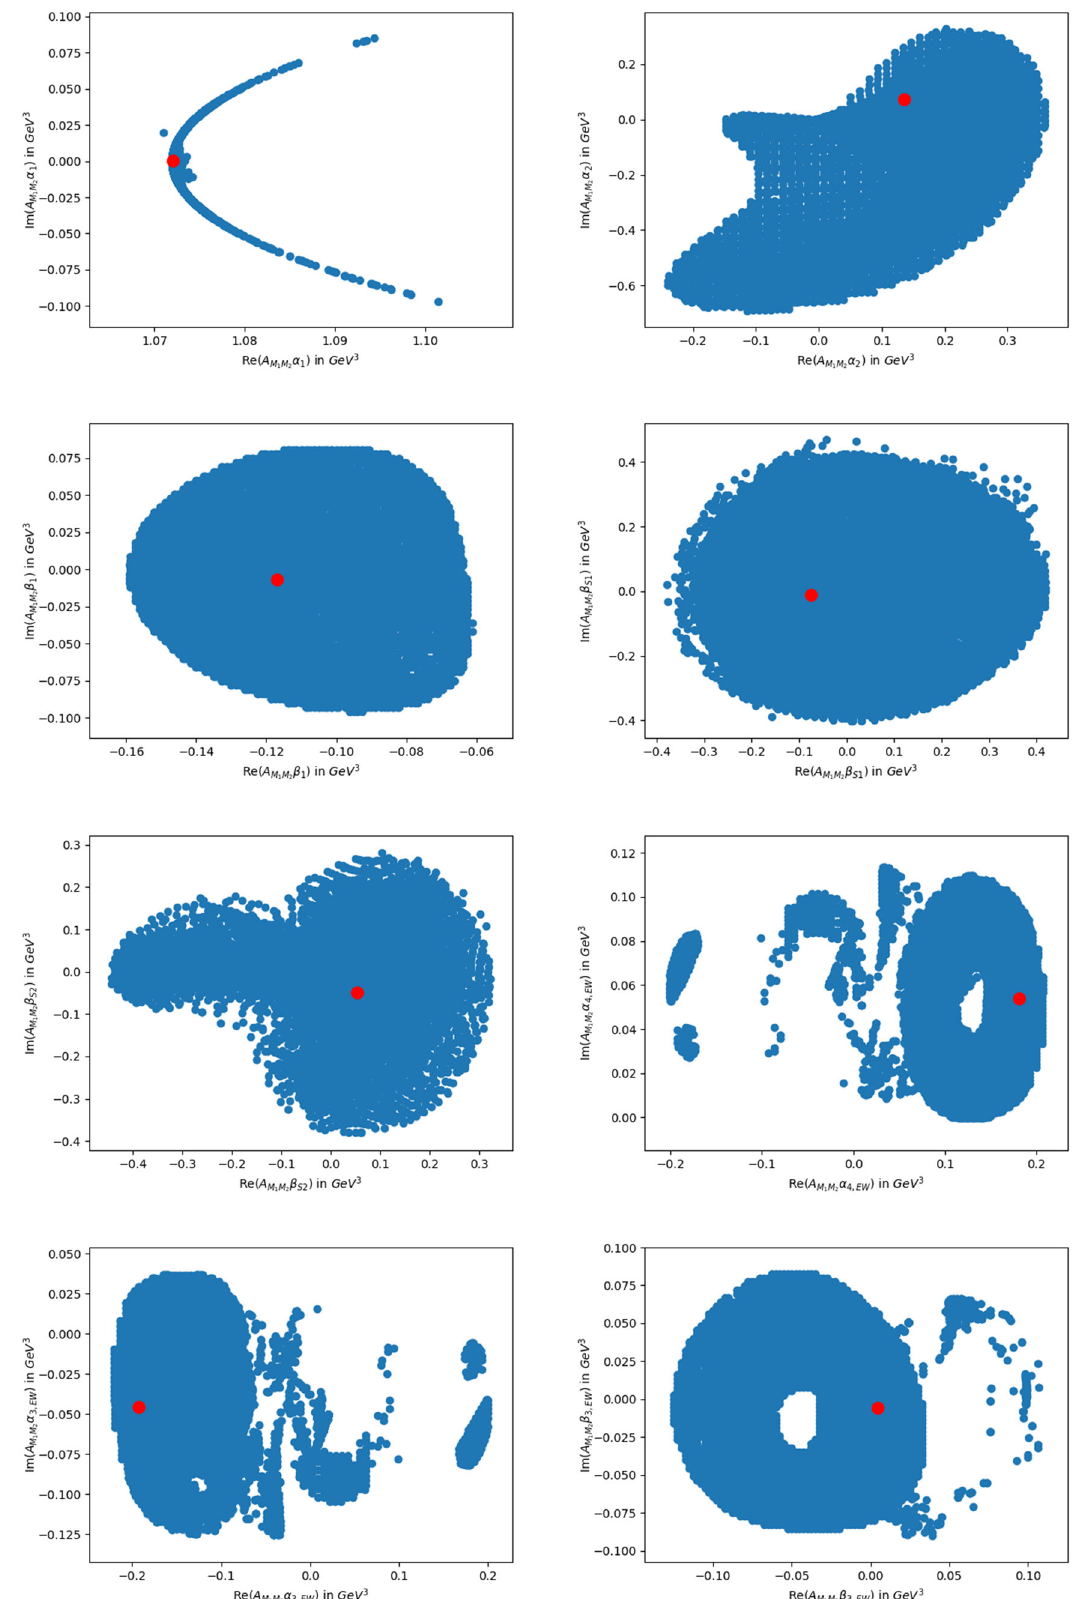
Fig. 5 QCDF fit, part1. Amplitudes carry units of GeV